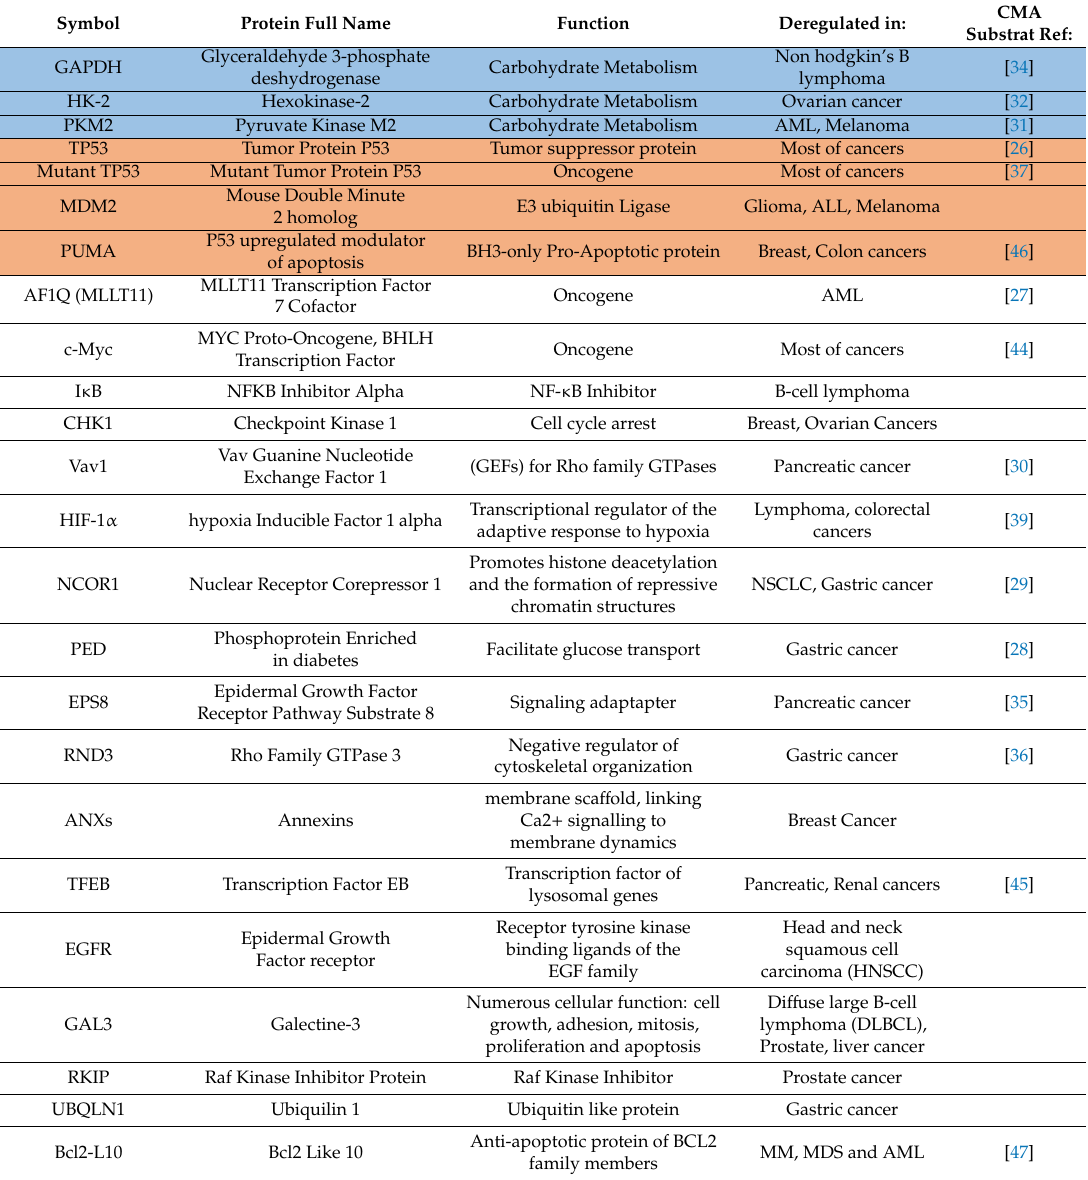
Table 1. CMA substrates with an established function in